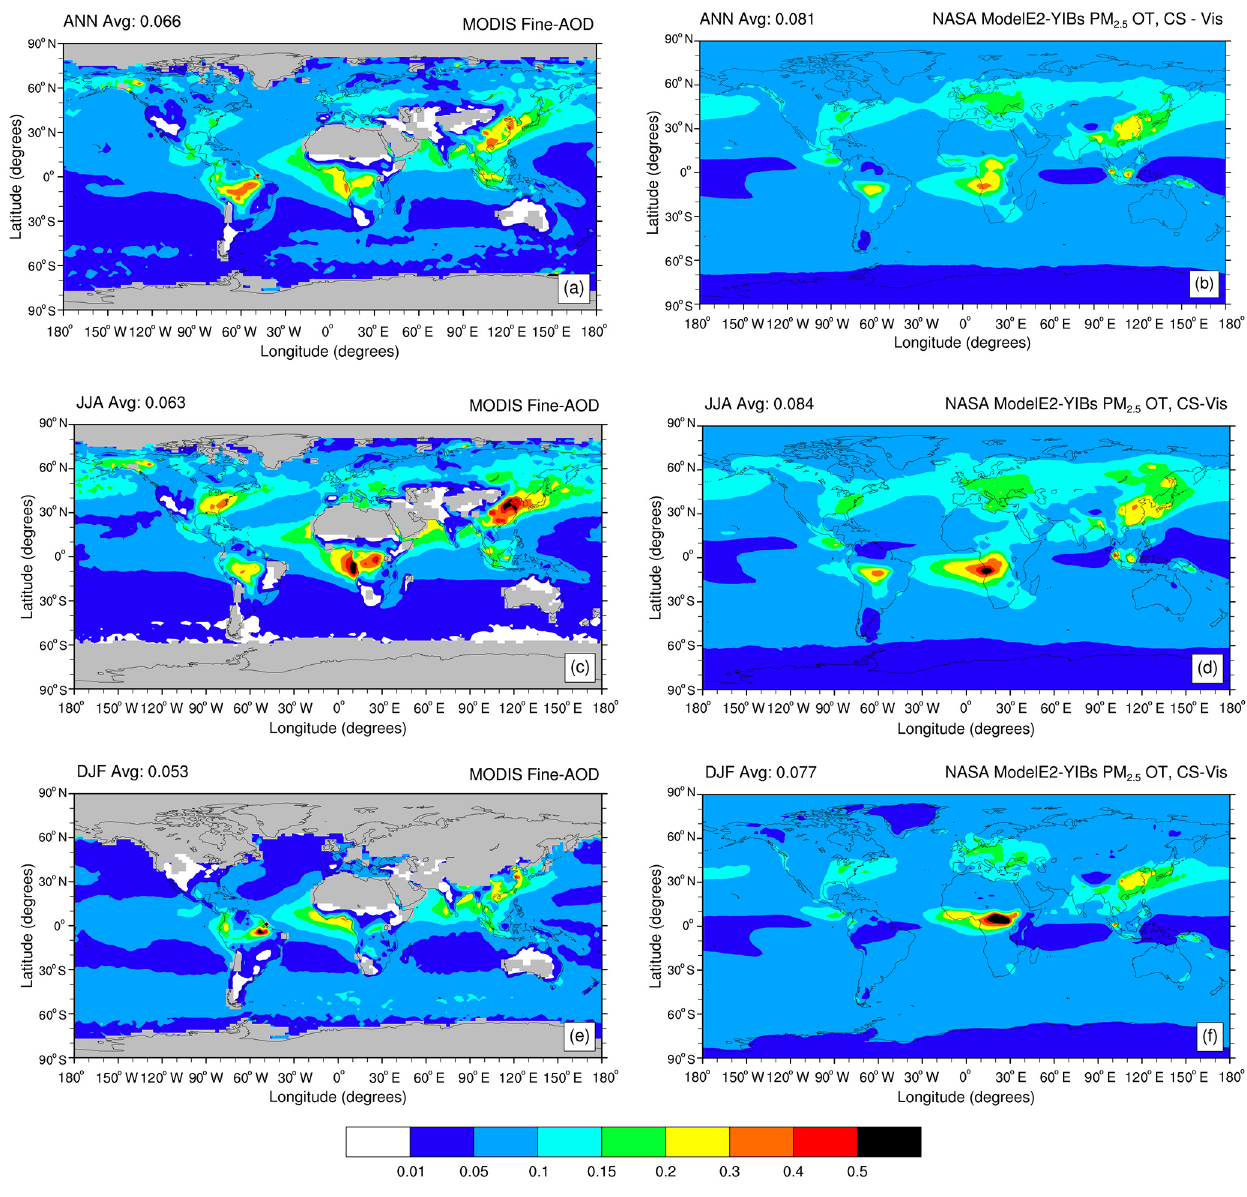
Figure 2. As Fig. 1 for fine-mode aerosol optical depth: (a, c, e) MODIS fine AOD and (b, d, f) model PM 2 . 5 OT.